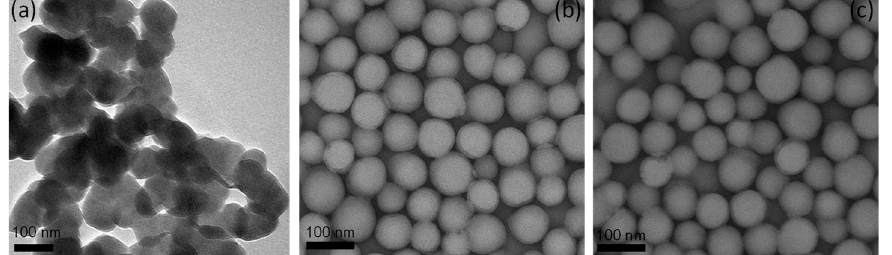
Figure 5. TEM of ( a ) E-44, and that of waterborne epoxy-styrene–acrylate composites with ( b ) conventional core-shell structure and ( c ) three-layer core-shell structure. 3.4. Determination of Intermediate Layer Thickness of Three ‐ Layer Core–shell Emulsion To identify thermal events, a DSC test was conducted (Figure 6a).